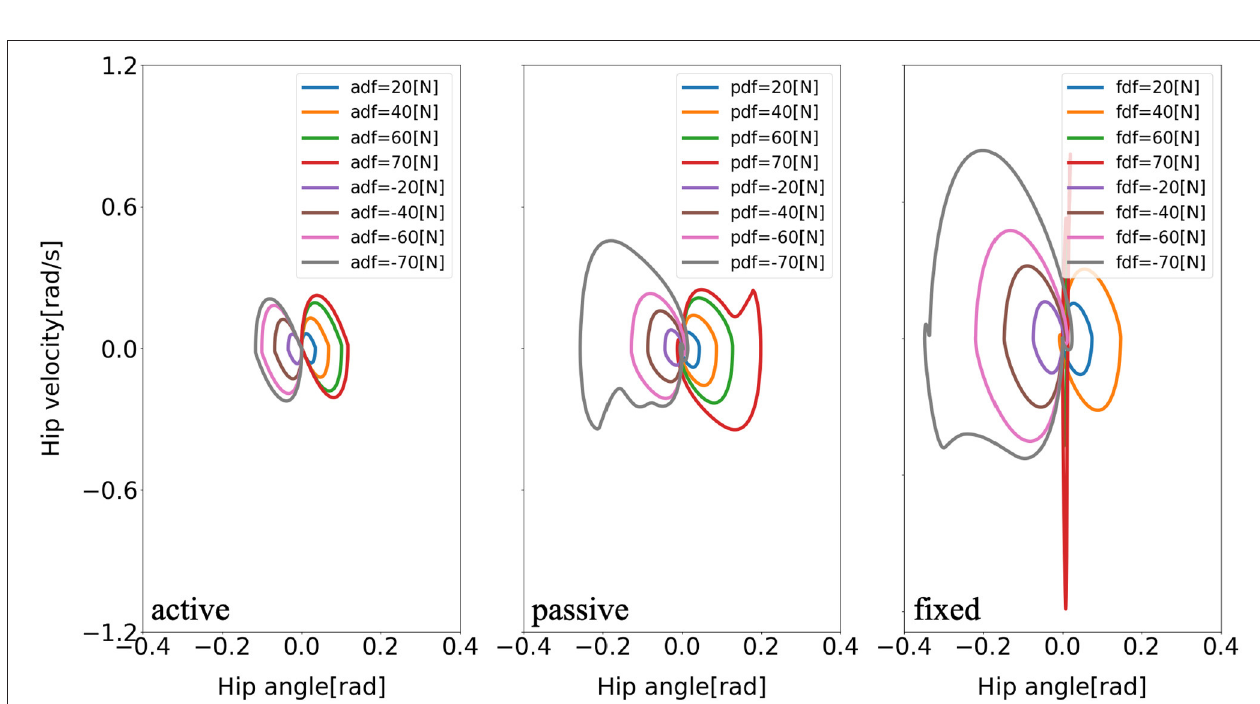
FIGURE 10 | Evolution of the hip phase portrait of the model for three different arm states (active arm, passive arm, fixed arm) for different disturbing forces: (1) Push backward: − 20 [ N ], − 40 [ N ], − 60 [ N ], and − 70 [ N ]. (2) No force: 0 [ N ]. (3) Push forward: 20 [ N ], 40 [ N ], 60 [ N ], and 70 [ N ]. “a,” “p,” and “f” in the labels “adf,” “pdf,” and “fdf” represent the cases with active arms, passive arms, fixed arms, respectively, and “df” represents the disturbing forces.